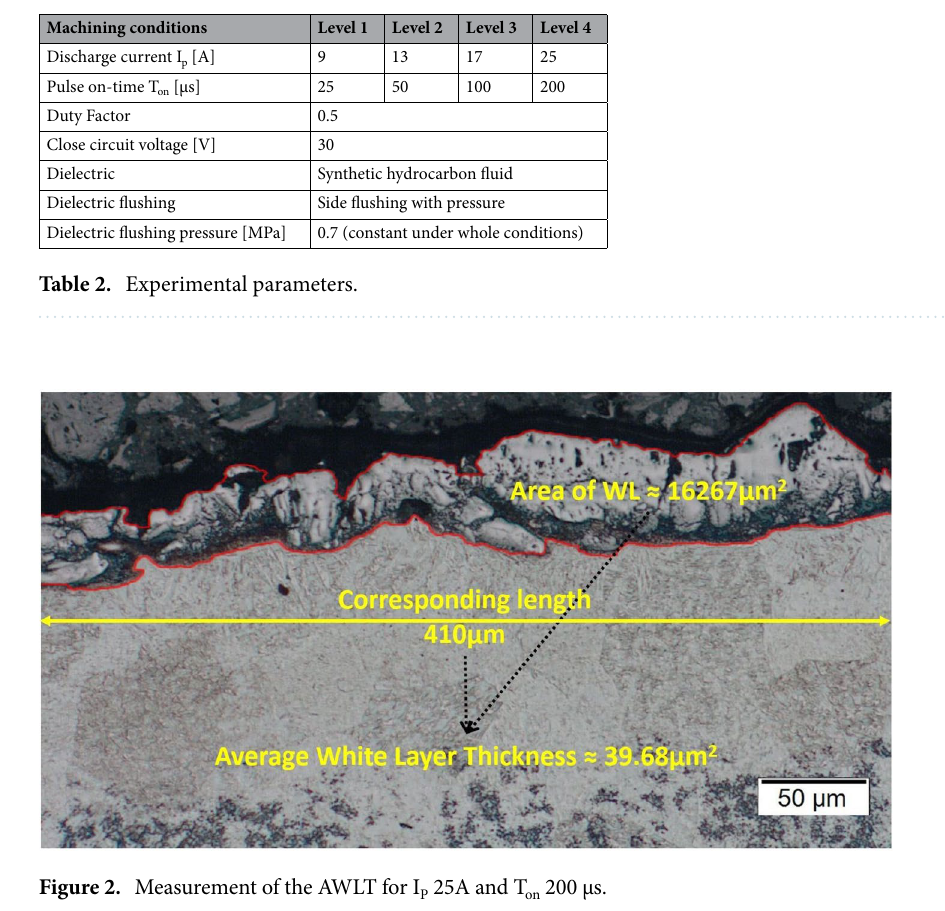
Figure 2. Measurement of the AWLT for I P 25A and T on 200